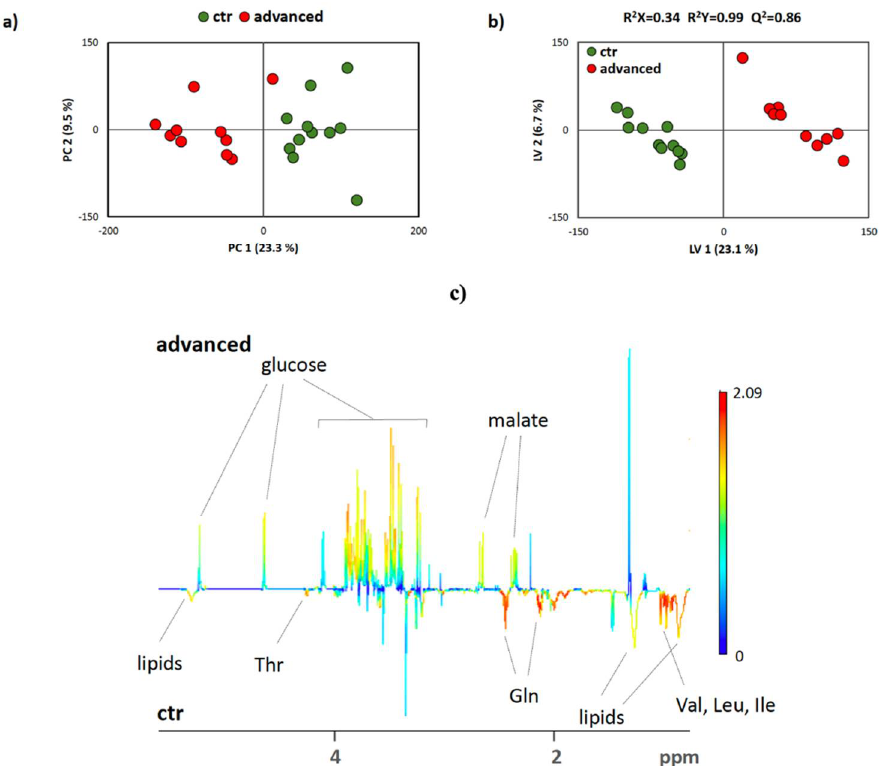
Figure 5. Scores scatter plots obtained via PCA ( a ) and PLS-DA ( b ) of 1D cpmg spectra of plasma from healthy control group and severe biliary AP patients. LV1 loadings extracted from PLS-DA are presented in ( c ). Loadings are colored according to variable importance of the projection (VIP), and some assignments are indicated.